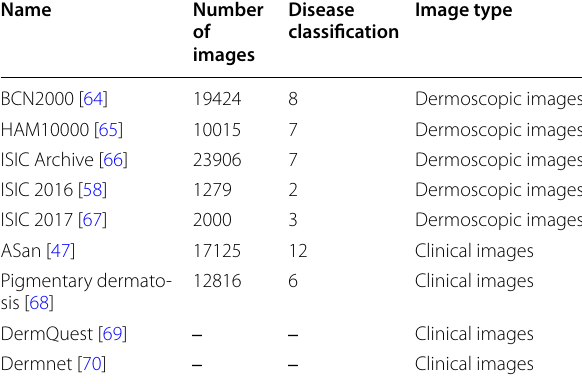
Table 3 Skin disease datasets